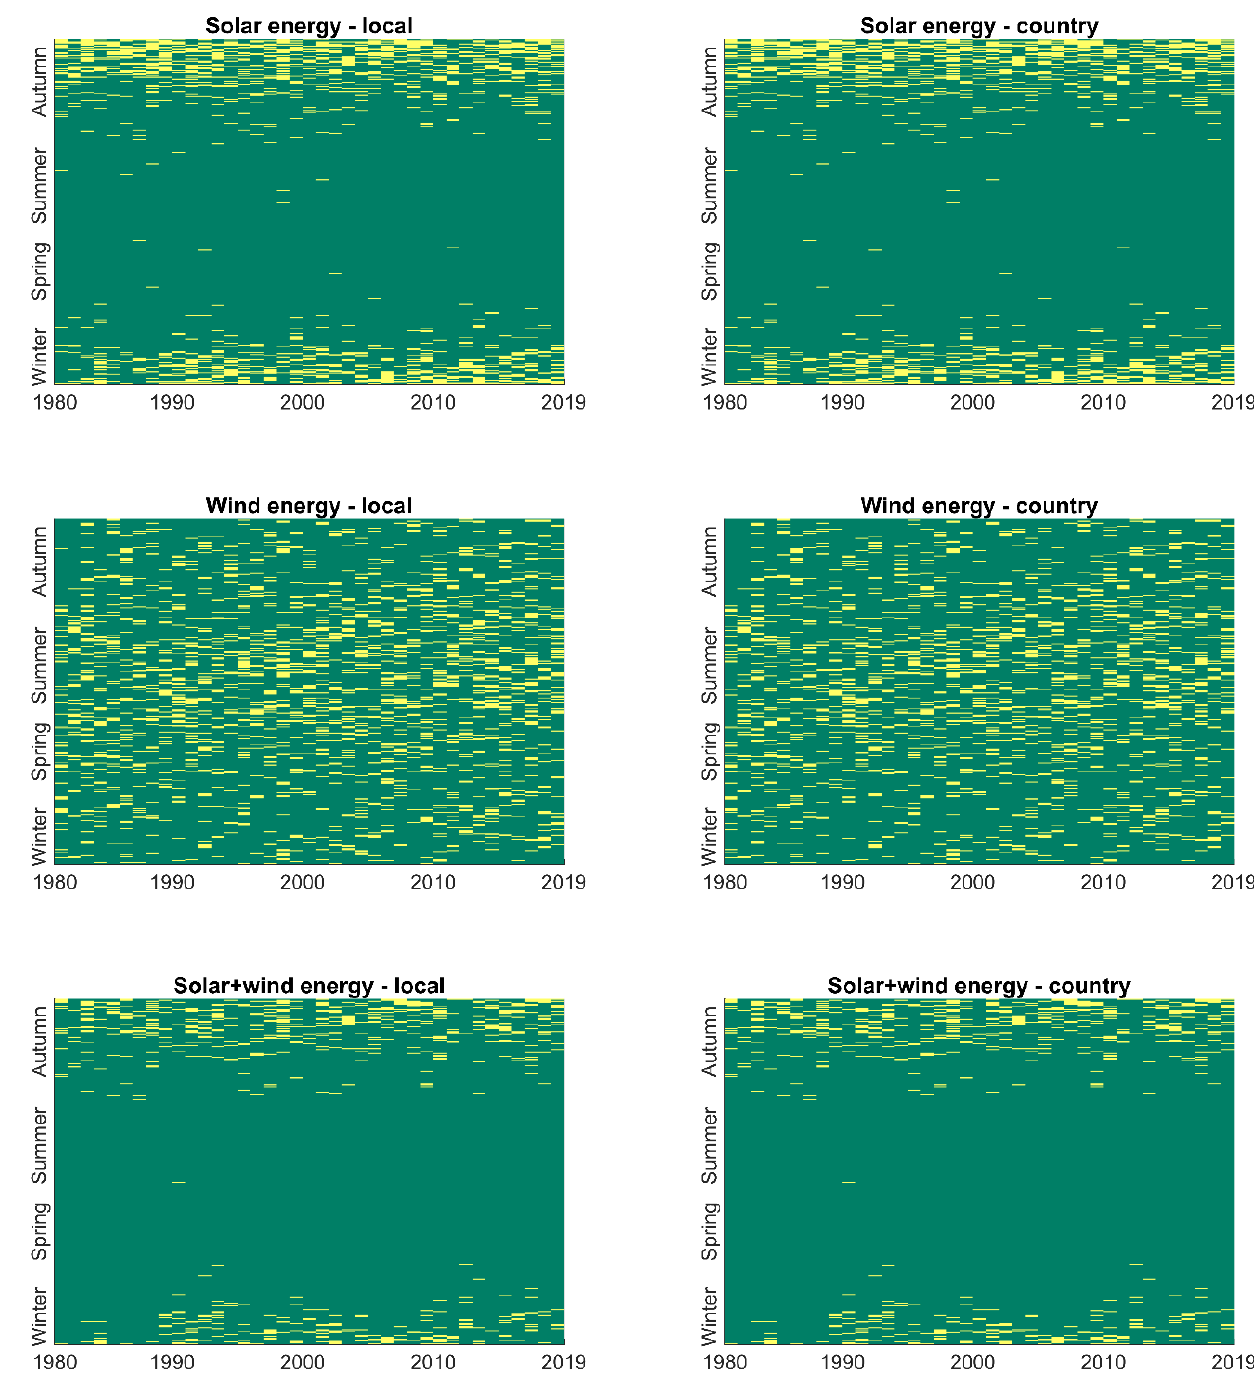
Figure 17. ‘Resource droughts’ (yellow) in Bełchatów region (central Poland). Left column presents local ‘resource droughts’, where the threshold for classifying a day as a ‘resource drought’ event was based on mean daily resources availability over the years 1980 – 2019. Right column presents a similar analysis, but with the threshold based on national mean (taking into account all grid points within Polish borders).